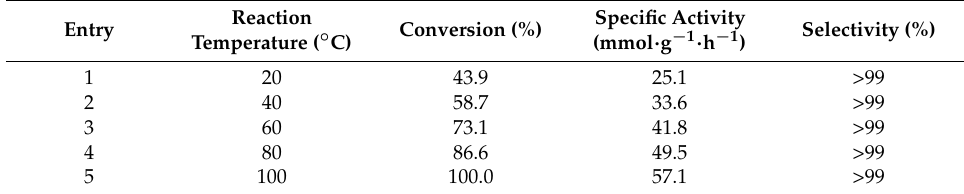
Table 4. Effect of reaction temperature on the catalytic